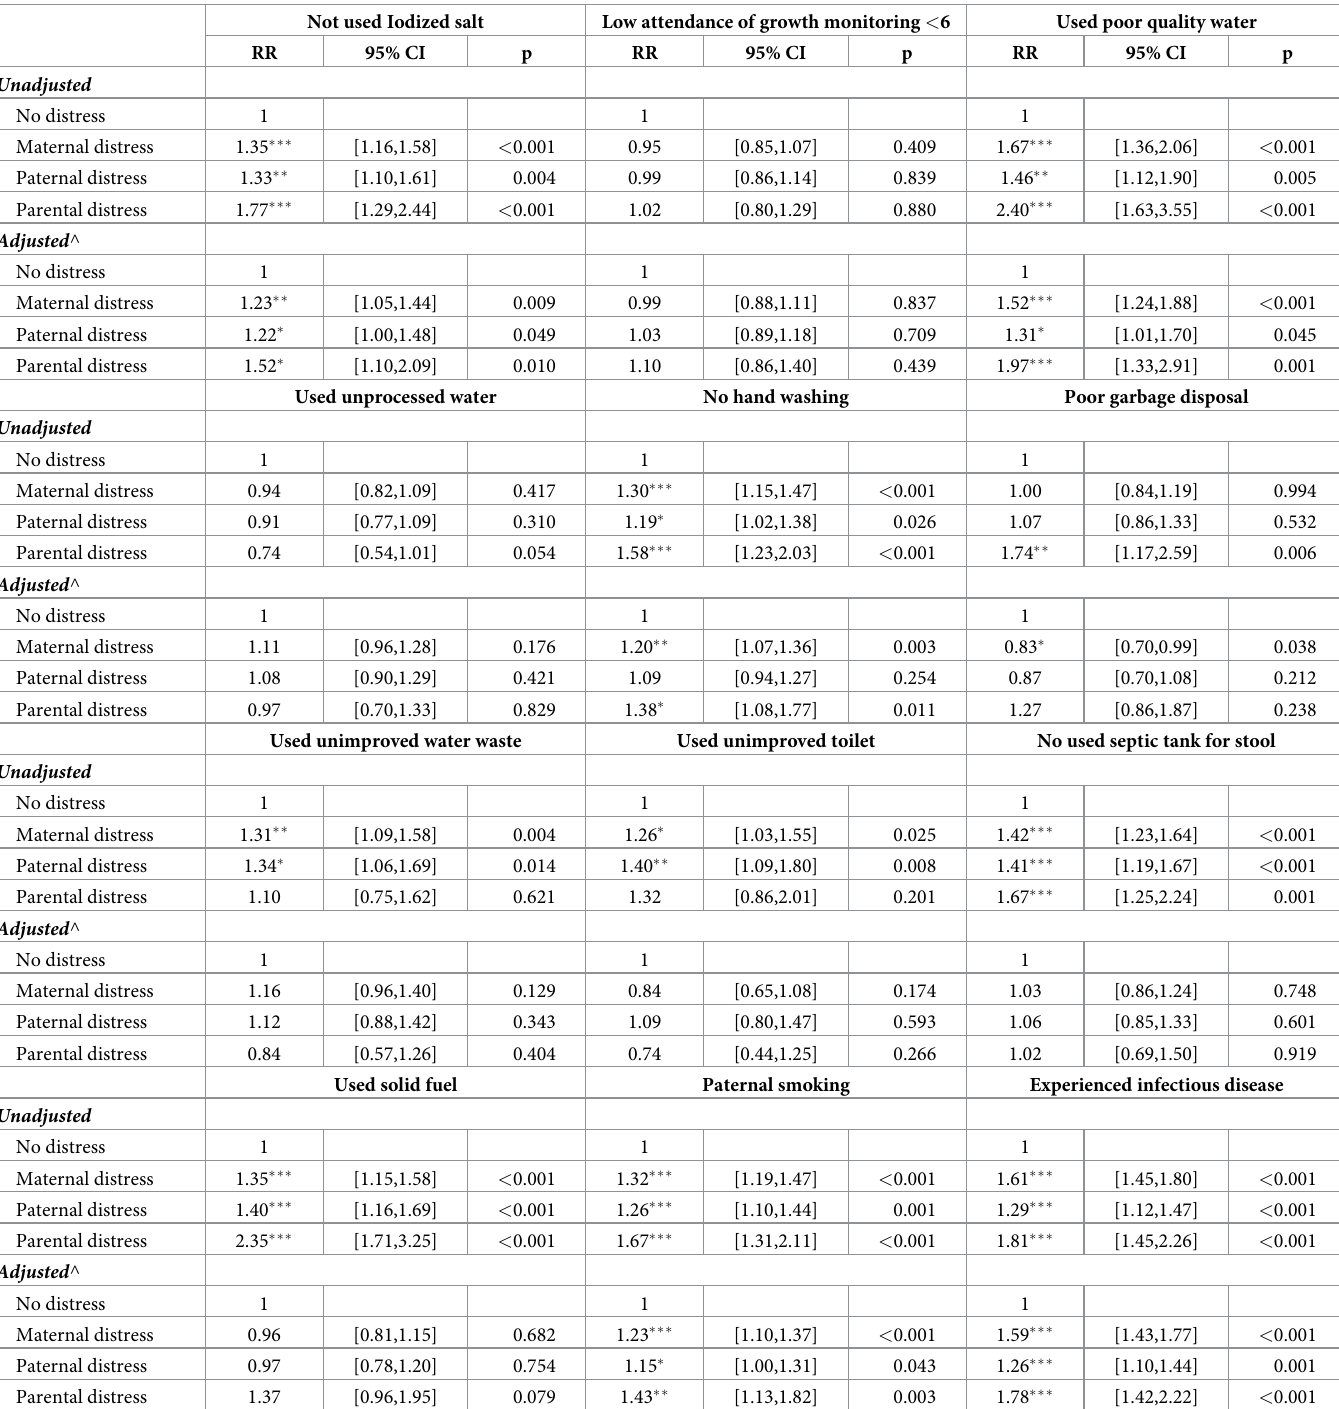
Table 3. Parental distress relation to behavioral and morbidity risk factors of